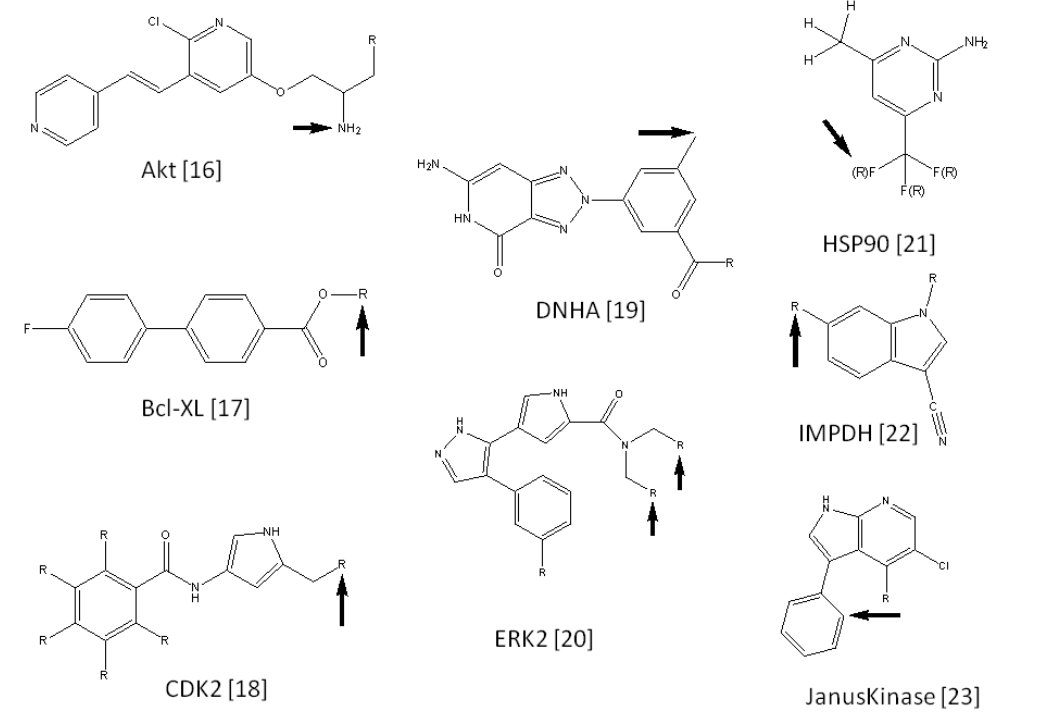
Figure 2. True active positions and predicted active positions. “R” represents the true active position, and the arrow represents the predicted active position by the current method by using side chain set